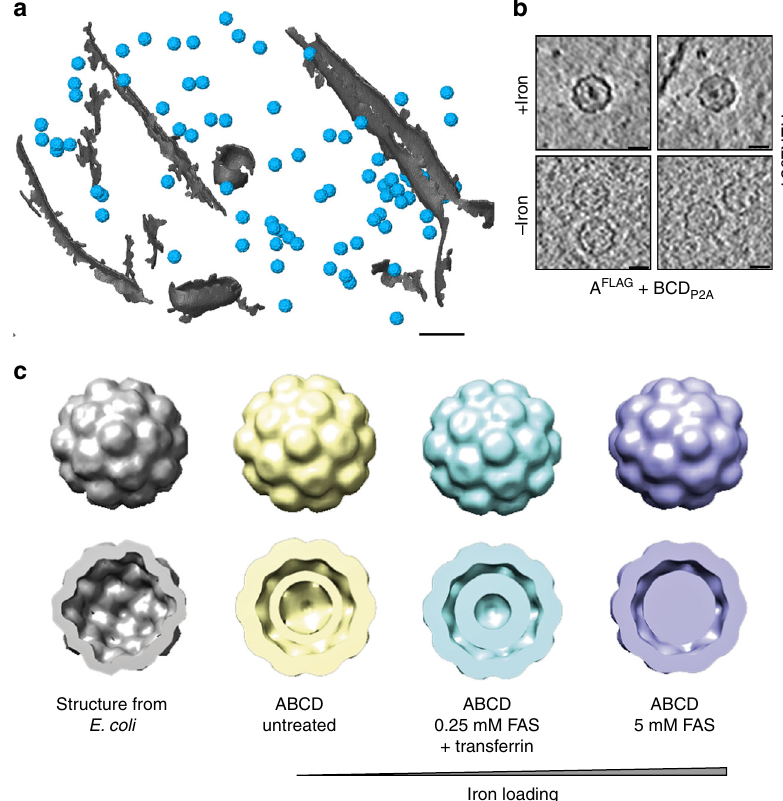
Fig. 8 Encapsulins as genetically encoded markers for cryo-electron tomography (Cryo-ET). a Cryo-ET data from HEK293T cells stably expressing encapsulins together with native ferritin-like cargo proteins (using the dual promoter construct A FLAG ;BCD P2A shown in Fig. 6a). 3D rendering showing encapsulins in blue and membranes in gray colors. Scale bar:100 nm. b Example slices from tomograms show encapsulins with and without electron-dense cores from iron-accumulation (treatment with 5 mM FAS for 48 h prior to vitri fi cation). Scale bars:20nm. c In situ structures (displayed as 2× binned) derived from cryoelectron tomography of nanocompartments assembled in HEK293T cells without (beige), with 0.25 mM FAS and 1 mg/ml human transferrin (cyan) and 5 mM FAS (purple) as compared with the published structure shown in gray (pdb 4PT2; EMDataBank EMD-5917) that was obtained from M. xanthus EncA expressed in E. coli 31 . The cutaway views of the encapsulins show electron densities indicating the presence of cargo proteins (beige) and additional iron deposition (cyan and purple) as compared to published data from the EncA shell 31 that were obtained in the absence of cargo